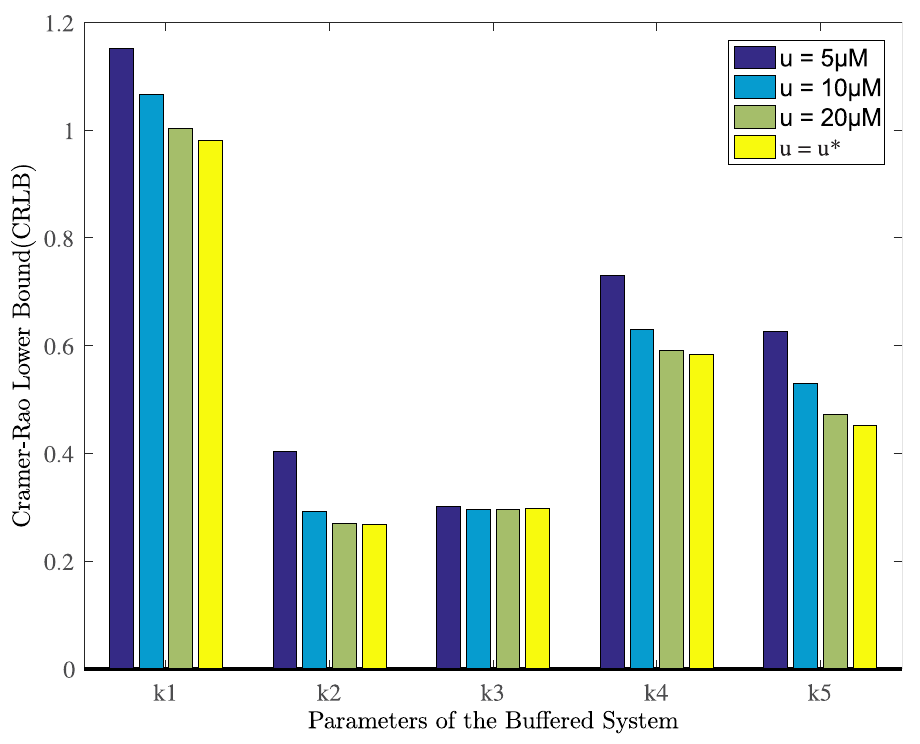
Fig 12. Cra´mer-Rao lower bound(CRLB) of kinetic parameters k 1 , k 2 , k 3 , k 4 and k 5 of the buffered system. Compared with three input levels i.e. u = 5 μM , 10 μM , 20 μM , the optimal input u � is able to reduce the values of CRLB for specific